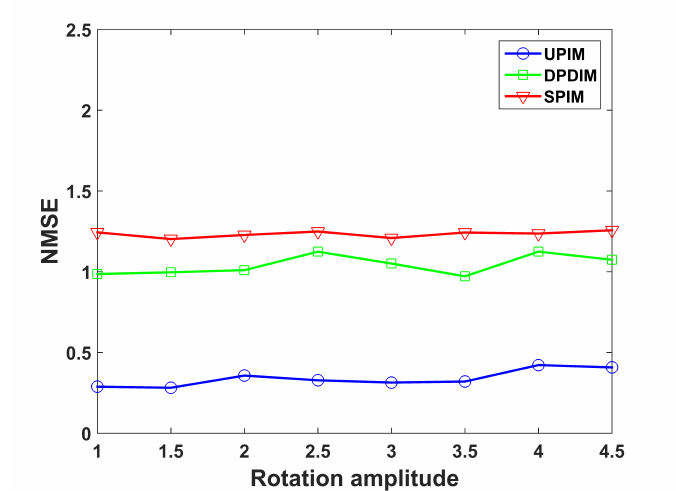
Figure 11. NMSE of the imaging results by UPIM, DPDIM, and SPIM at different amplitudes of